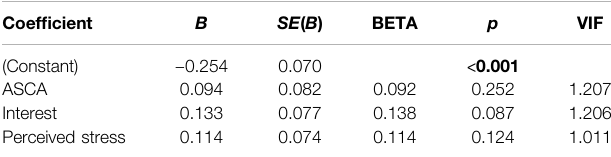
TABLE 7 | Linear regression analysis with variables ASCA, interest and perceived stress as predictor variables for mental effort (for the total sample).